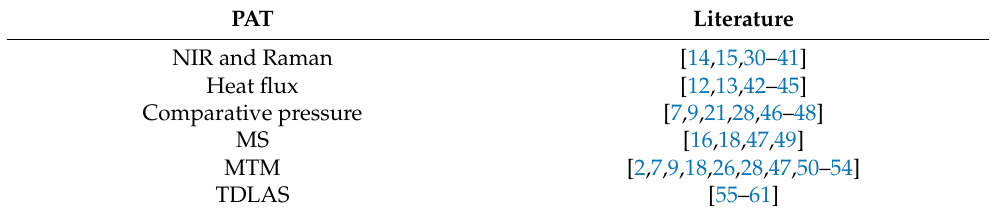
Table 2. Studies of different PAT.